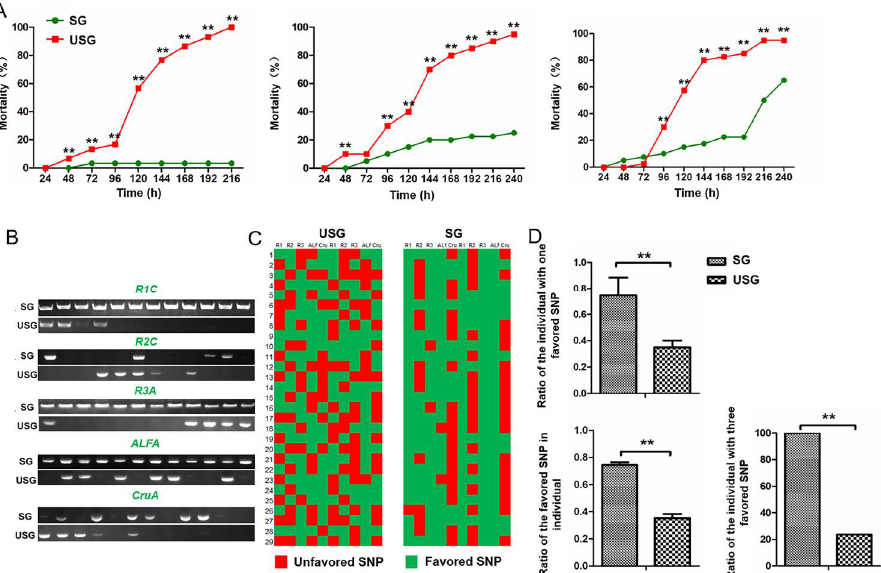
Figure 2. Genotypes and comparison of stress resistance of juvenile crayfish between selected group (SG) and unselected group (USG). ( A ) Mortality of juvenile crayfish stressed by transport (evaluated in triplicate). ( B ) Electrophoresis gel images of PCR products to detect SNP (R1, R2, R3, ALF, and Cru) genotypes of SG and USG individuals. ( C ) Genotype diagram of SG and USG individuals; horizontal (including two individuals per row) and vertical rows of rectangle represent different individuals and R1, R2, R3, ALF, and Cru SNP sites, respectively; the favoured SNP alleles are indicated by green squares include homozygous favoured and heterozygous genotypes. ( D ) Ratio of favoured genotypes between SG and USG. “**” indicates p <